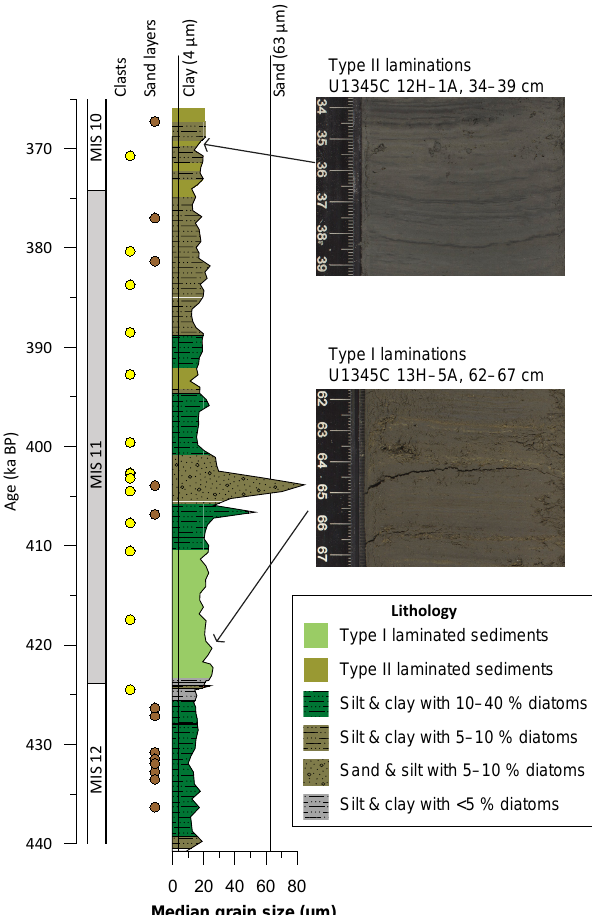
Figure 4. Lithostratigraphic column for U1345A. Marine Isotope Stage 11 is depicted as a grey bar. Ice-rafted debris (yellow dots) and sand layers (brown dots) are a compilation of these features in all four holes at U1345. The width of the lithologic column varies according to median grain size. Vertical lines indicate the cut-off for clay- and sand-sized particles. Silt lies between the two lines. Colors depict varying amounts of diatoms relative to terrigenous grains in the sediment. Type I laminations are depicted as pale-green bars and type II laminations are depicted as olive-green bars. An example of each of the lamination types is shown in the images to the